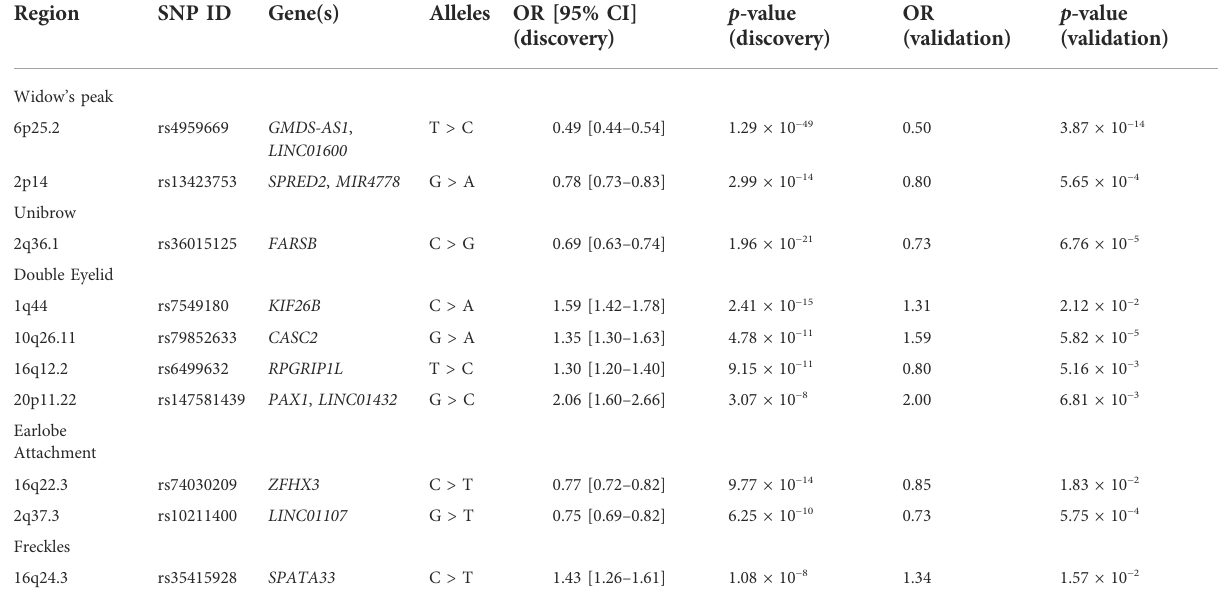
TABLE 1 Summary of previously unreported genome-wide signi fi cant